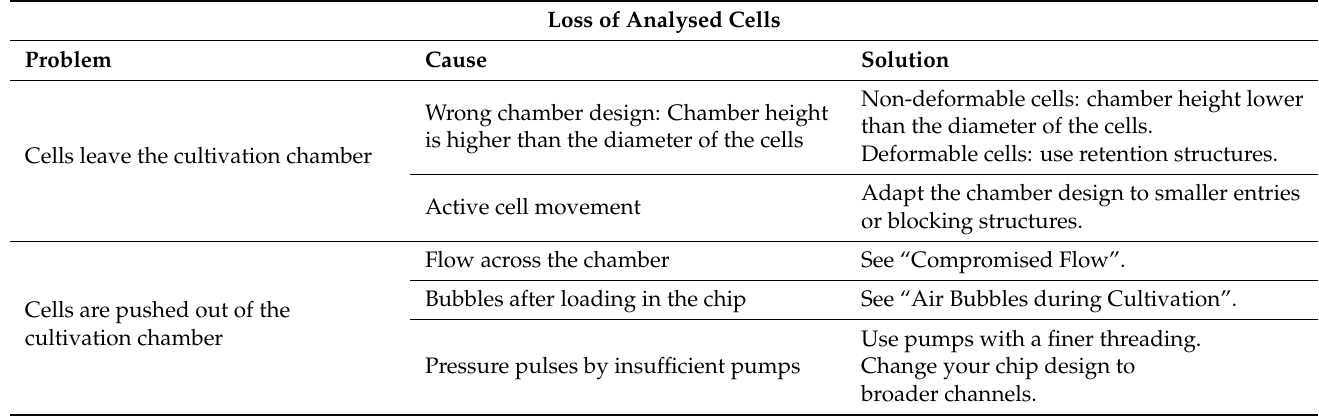
Table 7. Listed are the most frequently occurring challenges concerning loss of analysed cells with their respective cause and a suggested solution.